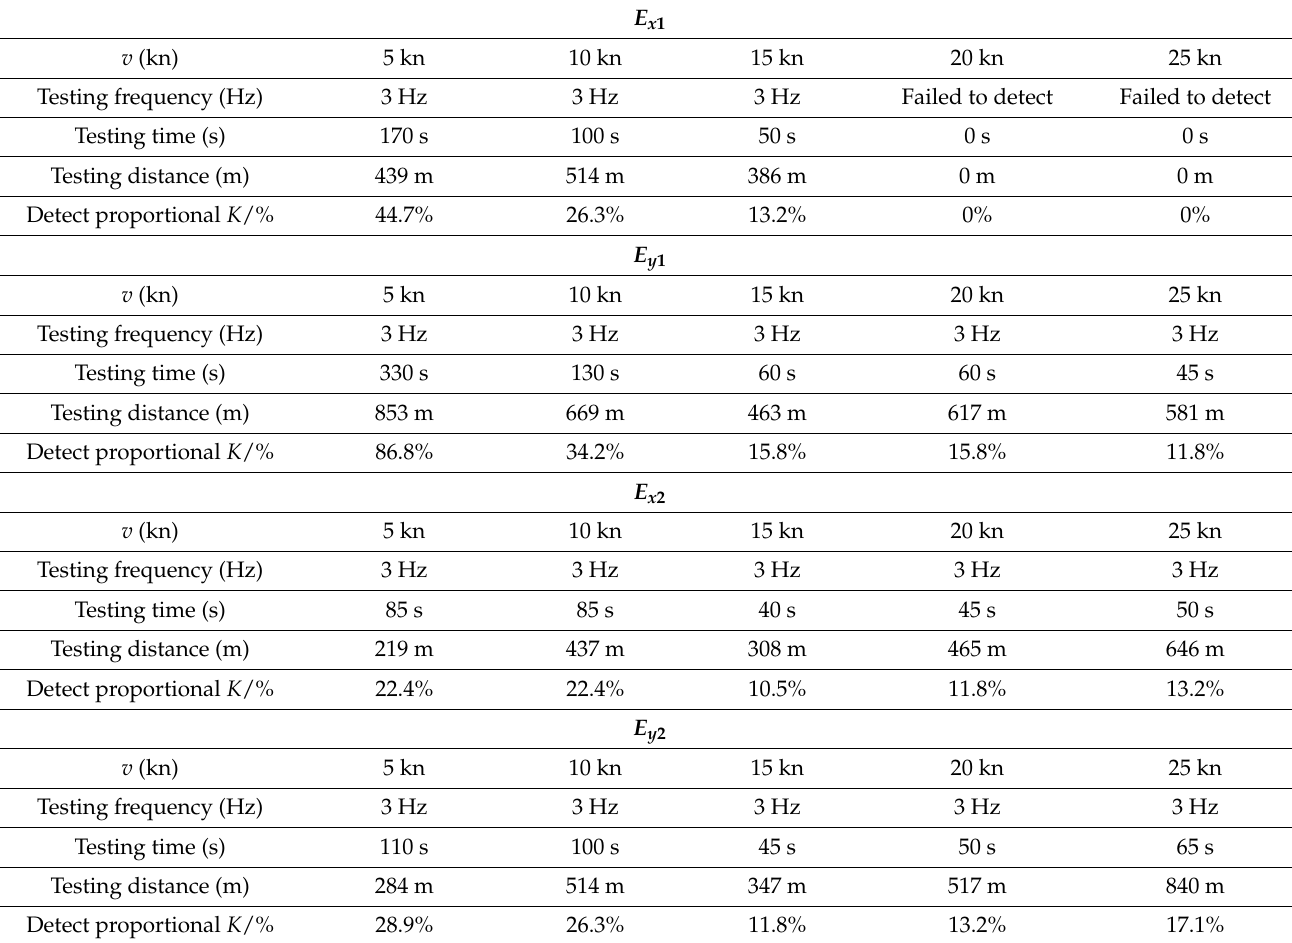
Table 2. Comparison of target electromagnetic field measurement results and line spectrum detection results when the measuring platform moves from low speed to high speed in turn. E x